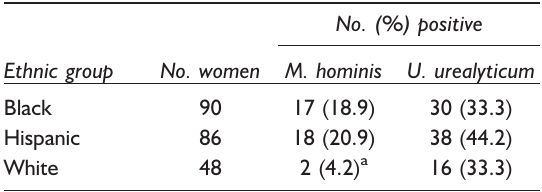
Table 1 Relation between ethnicity and vaginal coloni- zation with M. hominis and U.